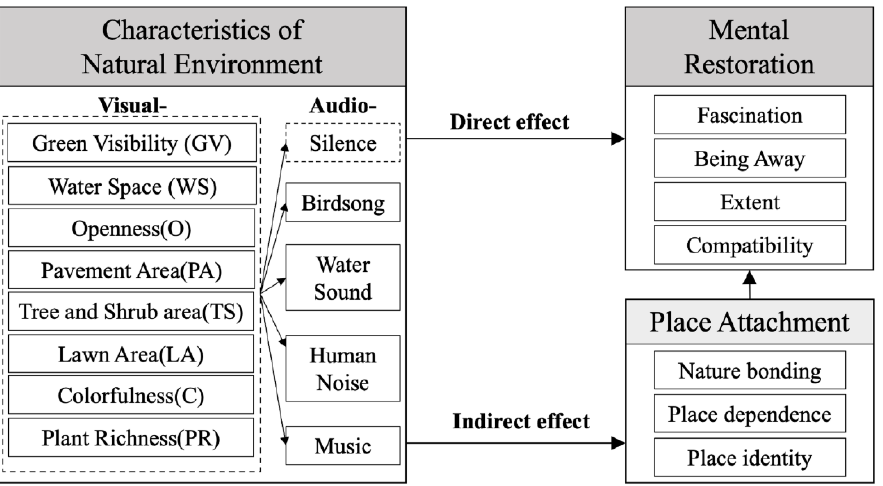
Figure 5. Theoretical framework of the Structural Equation Model (SEM).